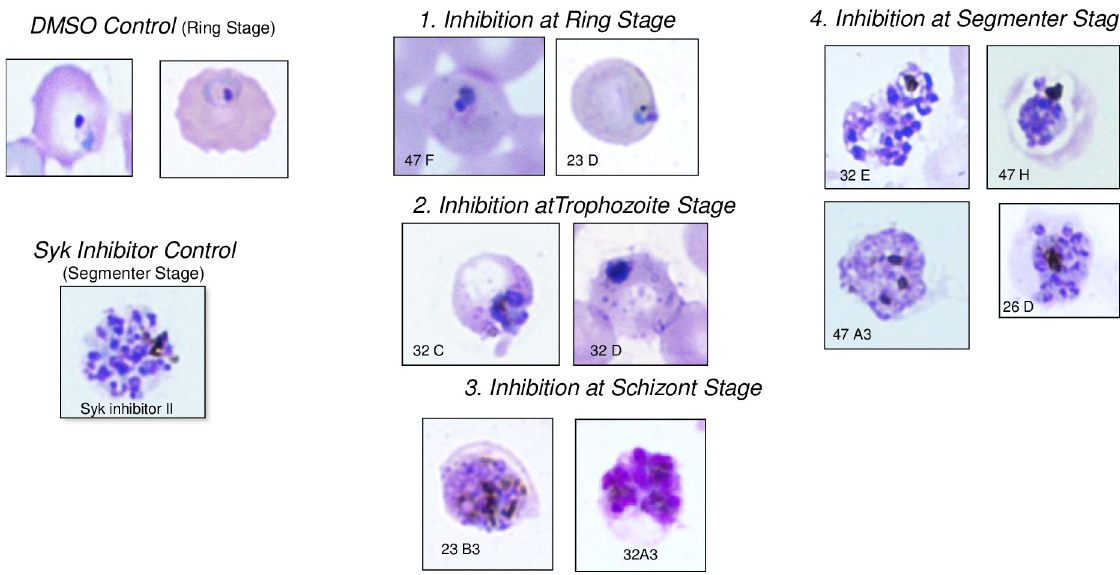
Fig 3. Images of blood smears of parasite cultures obtained 66 hours post invasion. Top left: Untreated (DMSO control) showing infected RBCs have progressed to the ring stage of their second life cycle after successful egress at the end of their first life cycle). Bottom left: Positive control of parasites treated with the well-known Syk inhibitor II showing stalled egress at the end of the first life cycle. Panels 1, 2, 3 and 4: Blood smears displaying the stages at which the de-identified drug terminated parasite maturation. Inhibitors 47F and 23D halted parasite maturation at ring stage, while 32C and 32D appear to halt the parasite at the trophozoite stage. Inhibitors 23B3 and 32A3 interrupted parasite development at the schizont stage. Syk phenotype inhibitors; 32E, 47H, 47A3 and 26D appear to stop the parasite from egressing at the segmenter stage as evidenced by the separated merozoites within infected